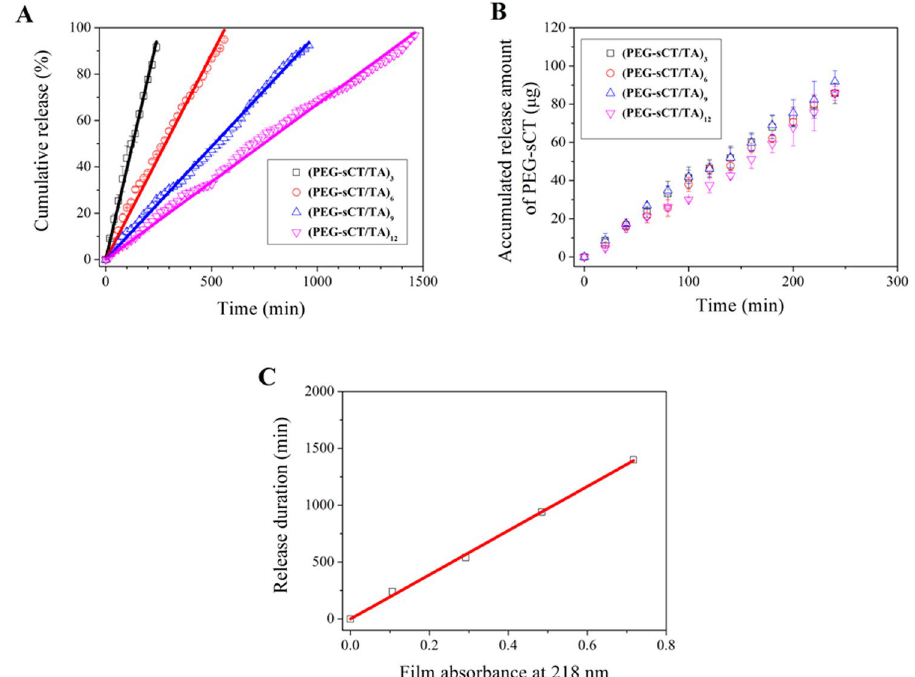
Figure 4. ( A,B ) Release of PEG-sCT from different bilayer number of PEG-sCT/TA films drawn as percentage release ( A ) and cumulative released amount ( B ). ( C ) Release duration (represented as time for 90% release) as a function of film thickness (represented as the absorbance of the original film at 218 nm). Release media: 50 mM pH7.4 phosphate buffer. T = 37 °C.